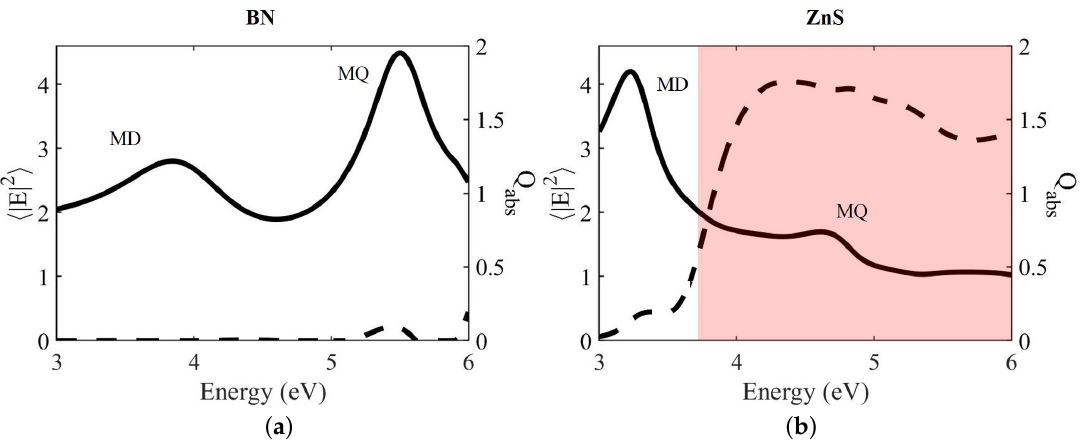
Figure 3. Surface averaged electric field intensity (solid line, left axis) and absorption efficiency (dashed line, right axis) for ( a ) BN and ( b ) ZnS nanospheres of 70 nm radius. The red shaded area indicates the range where (cid:101) 2 >